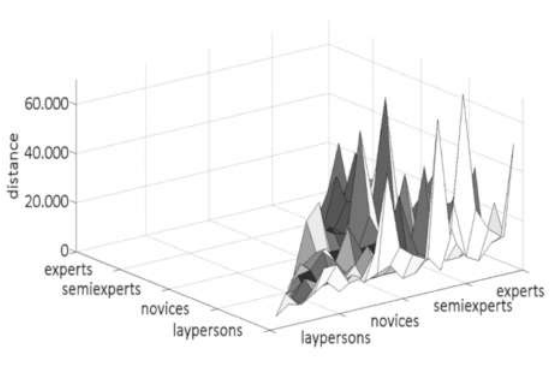
Figure 5. Distances of the fixation locations between all participants on the sculpture Daphne.